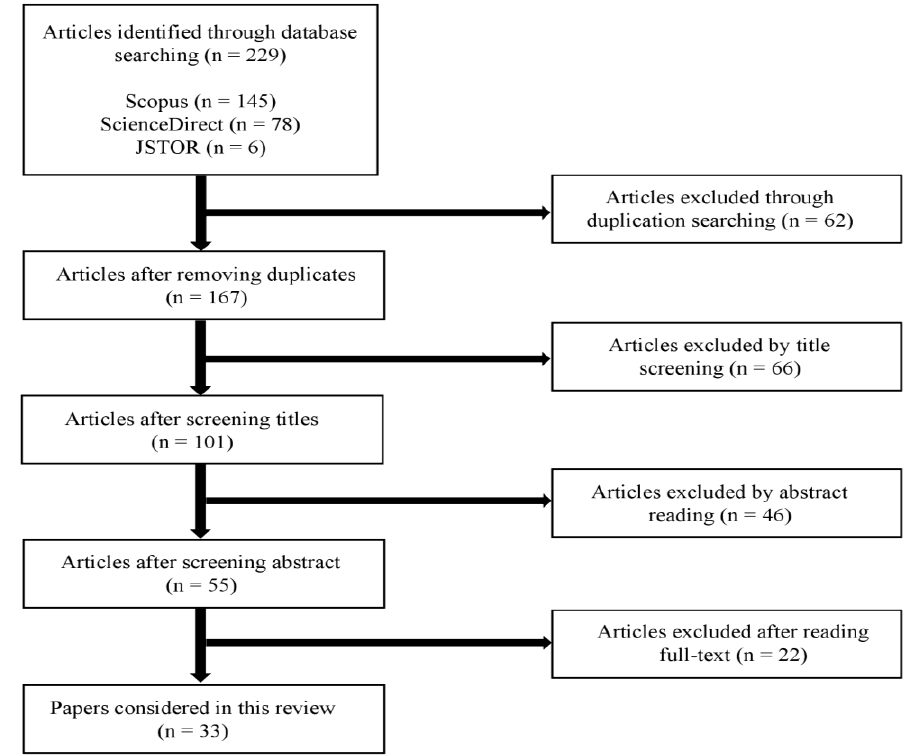
Figure 2. Review